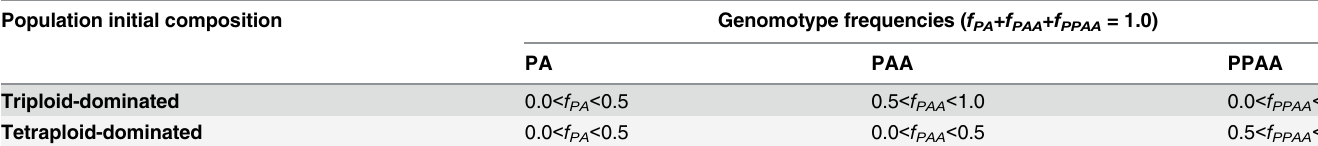
Table 2. Ranges of genomotype frequencies used to generate the initial population compositions for the model. All initial genomotype compositions were aimed at recreating triploid- and tetraploid-dominated populations and used as starting points for all sets of simulations. Population initial